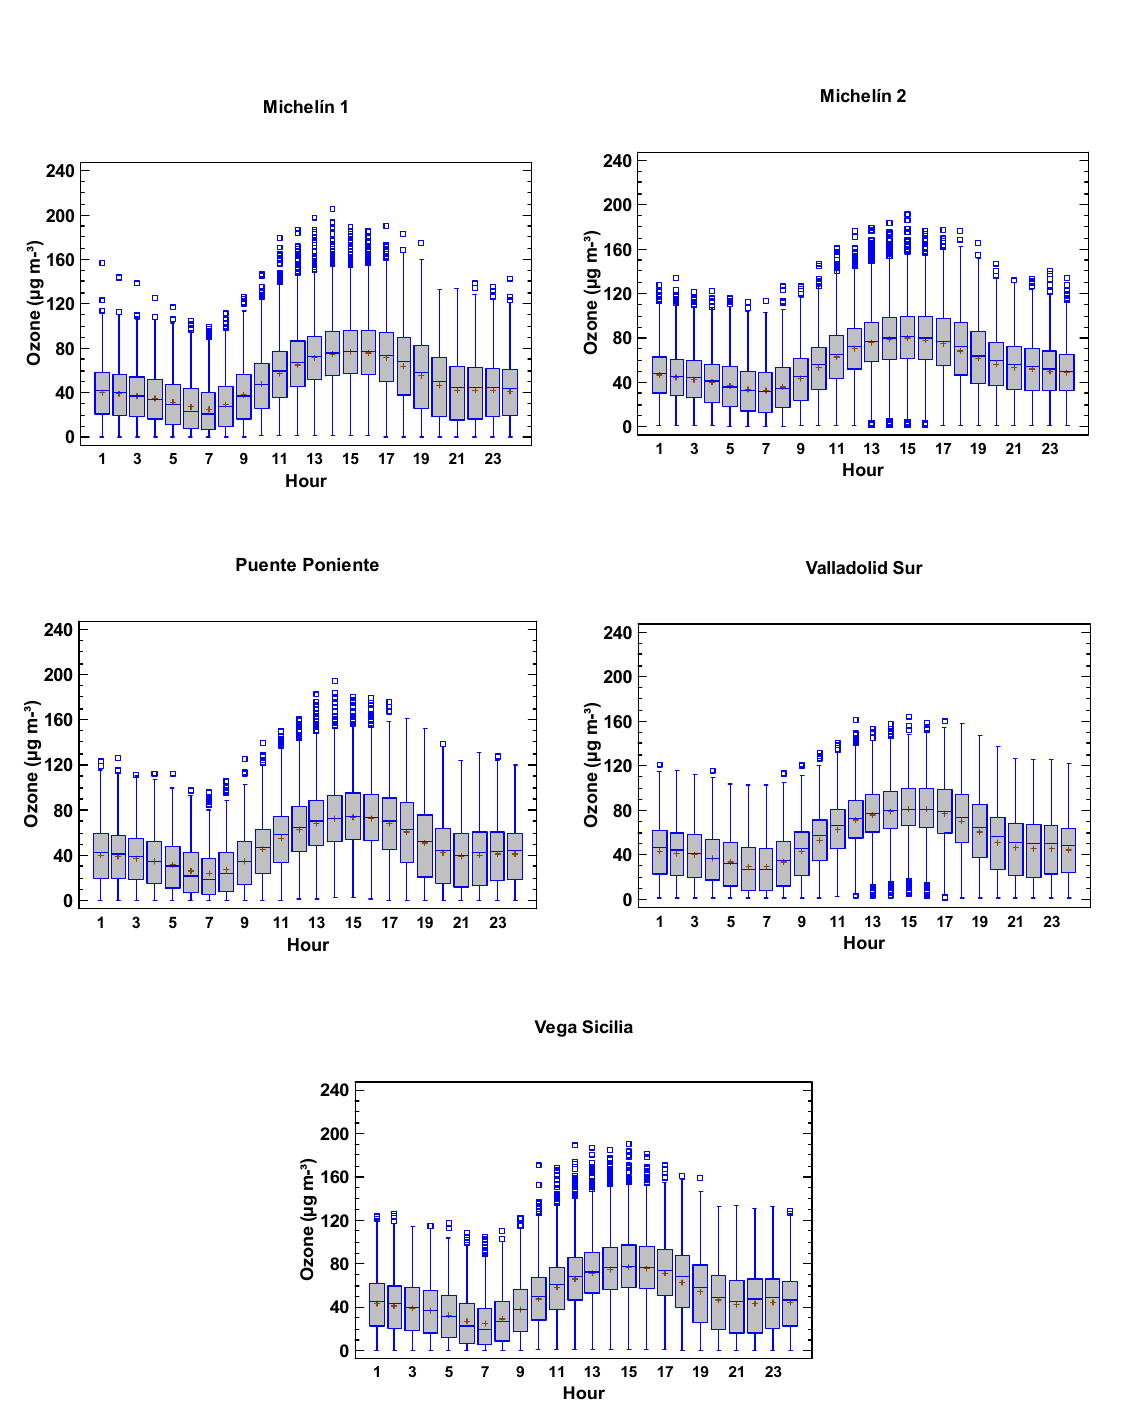
Figure 3. Hourly evolution of ozone concentrations at each measuring station in the study period. The monthly mean pattern over the study period is shown in Figure 4 on an hourly basis, and is similar to those recorded at Mediterranean locations [26,27]. Ozone levels increased during the first months of the year for all the measuring stations, and reached the maximum value in July, which is mainly associated with the photochemical period [28] characterised by dry and sunny weather conditions. There was a secondary peak in May and June whose origin is not as clear. It might be related to stratospheric–tropospheric interchange, which generally occurs between January and June, the increase in solar radiation and the long-range transport of ozone [2,12,29]. Data variability was